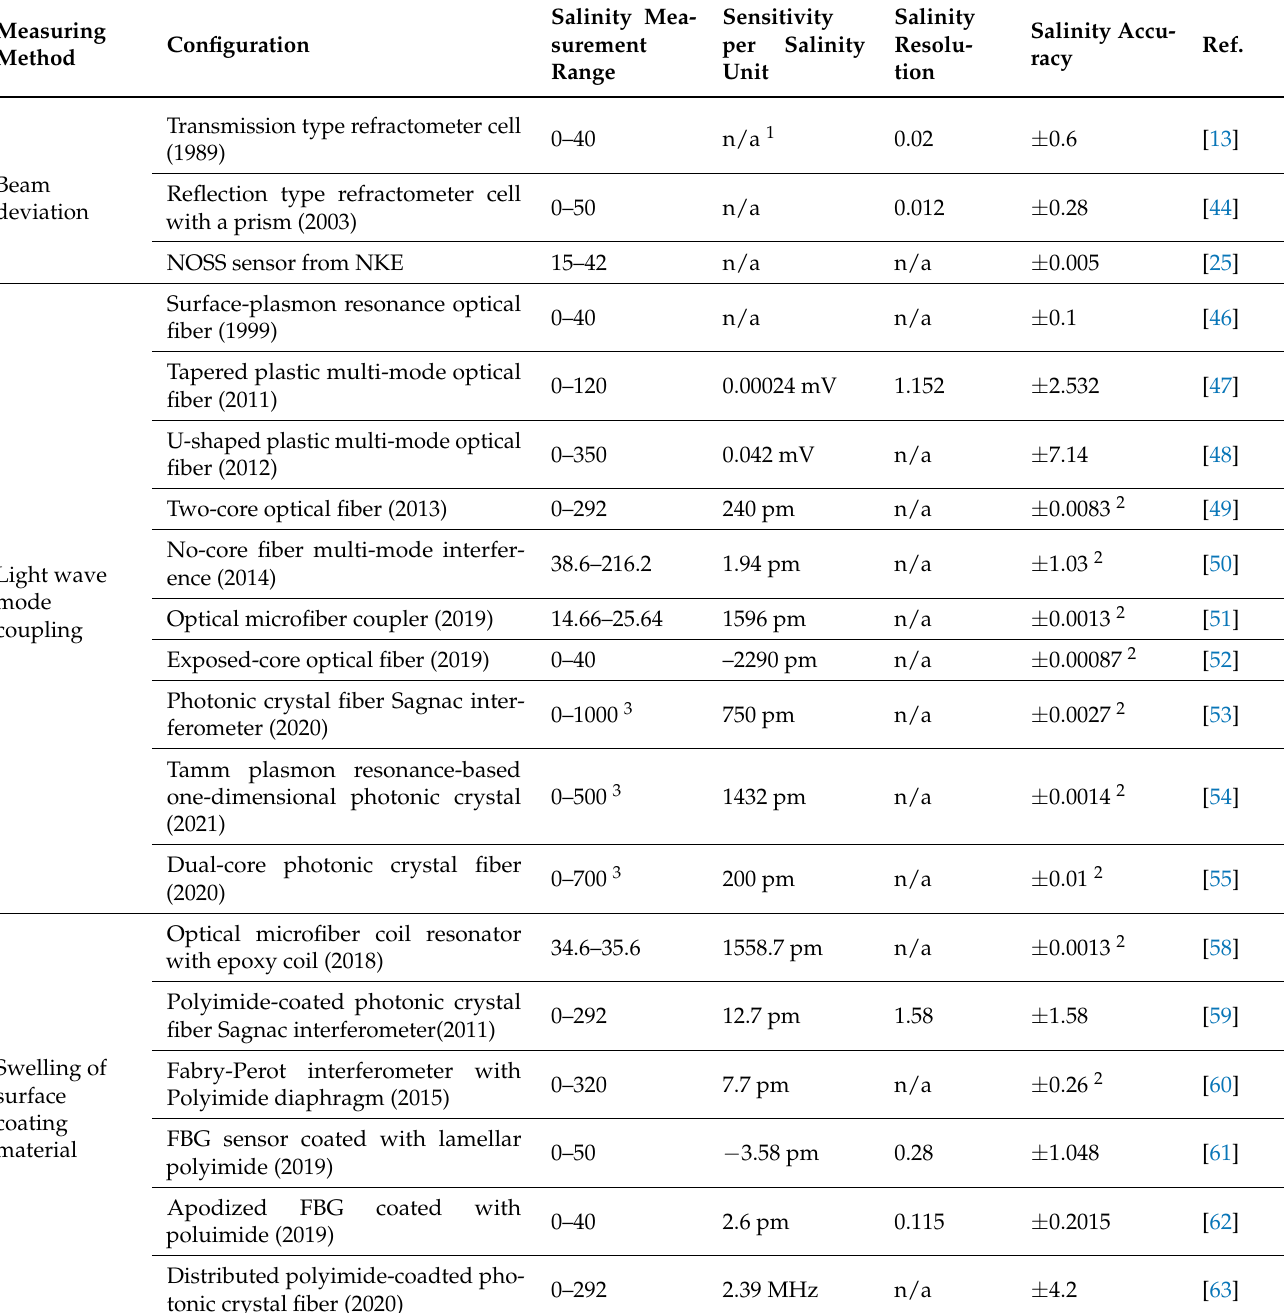
Table 4. The comparison of various optical salinity